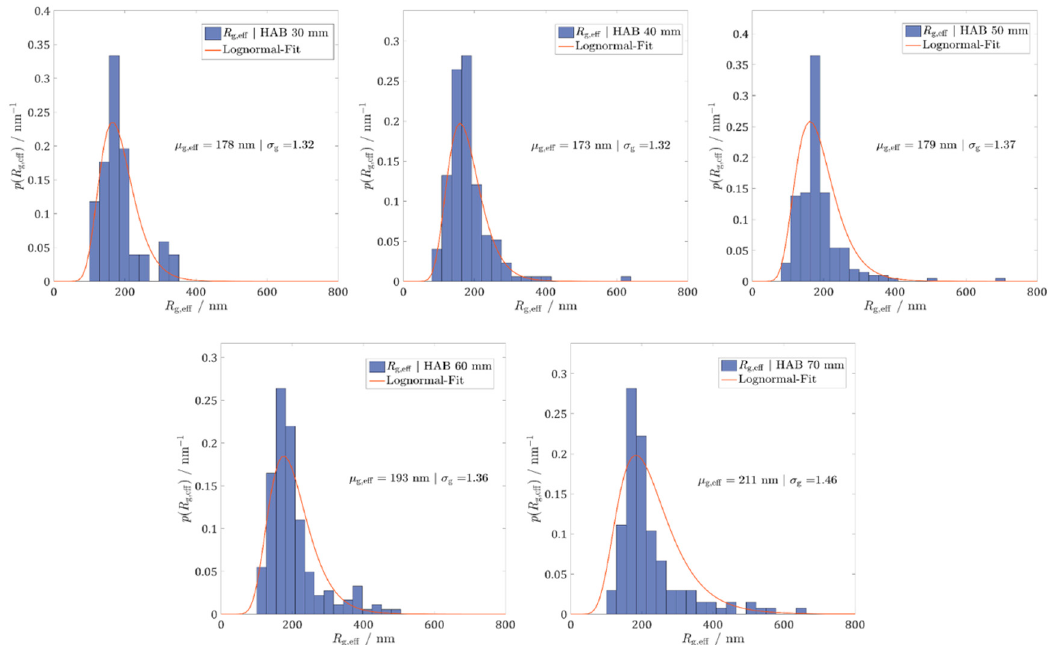
Figure 13. Distribution of the effective R g,eff at 30, 40, 50, 60, and 70 mm HAB for the reference diesel CEC RF-06-03.